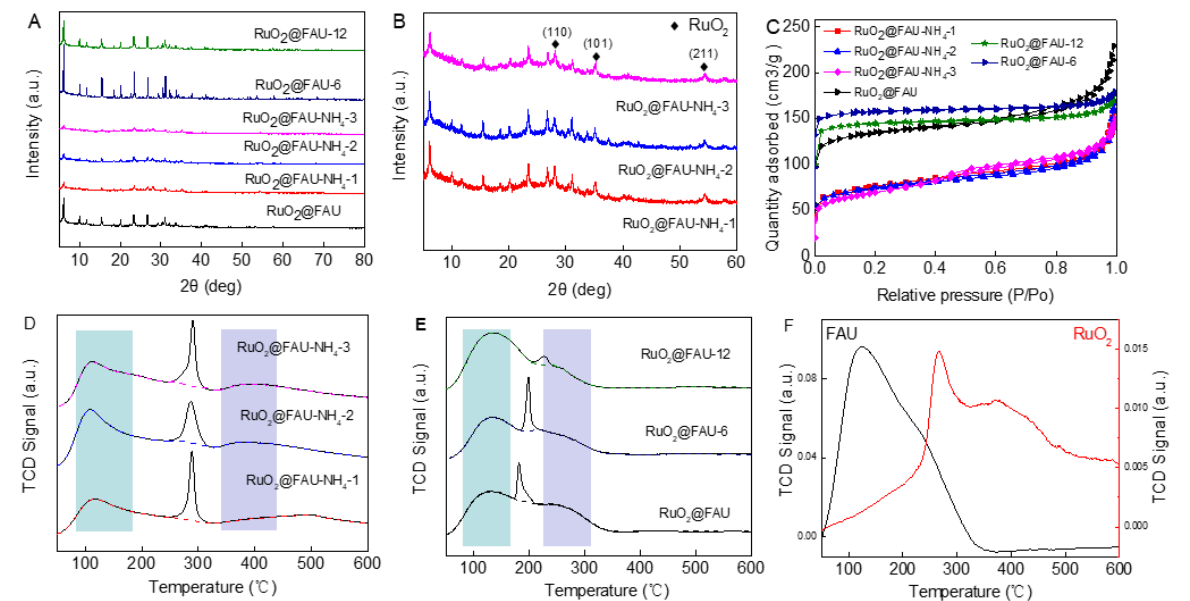
Figure 3. Characterizations of different catalysts. ( A ) XRD patterns of all catalysts, ( B ) enlarged XRD patterns of RuO 2 @FAU-NH 4 - i catalysts between 5 and 60 degrees, ( C ) Nitrogen adsorption and desorption isotherms curves of all catalysts, ( D ) NH 3 -TPD curves of RuO 2 @FAU-NH 4 -i catalysts, ( E ) NH 3 -TPD curves of RuO 2 @FAU-x catalysts, the light-blue rectangle in ( D , E ) represents weak acid sites, and the light-purple rectange represents medium strong acid sites, ( F ) NH 3 -TPD curves of RuO 2 and